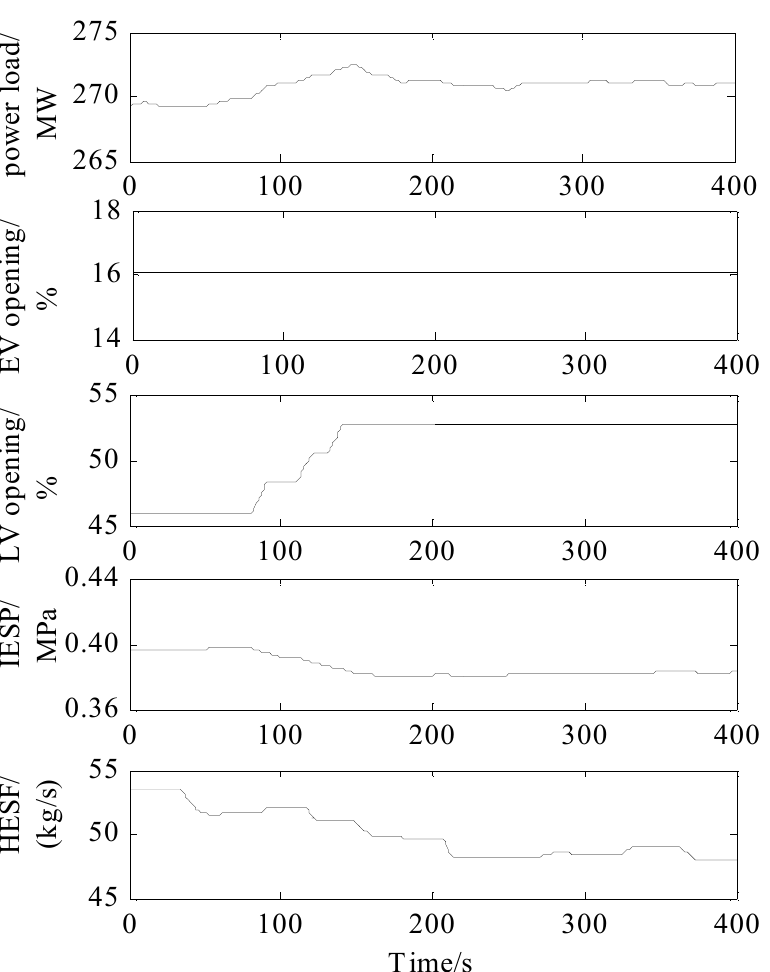
Figure 4. Dynamic response to EV opening.